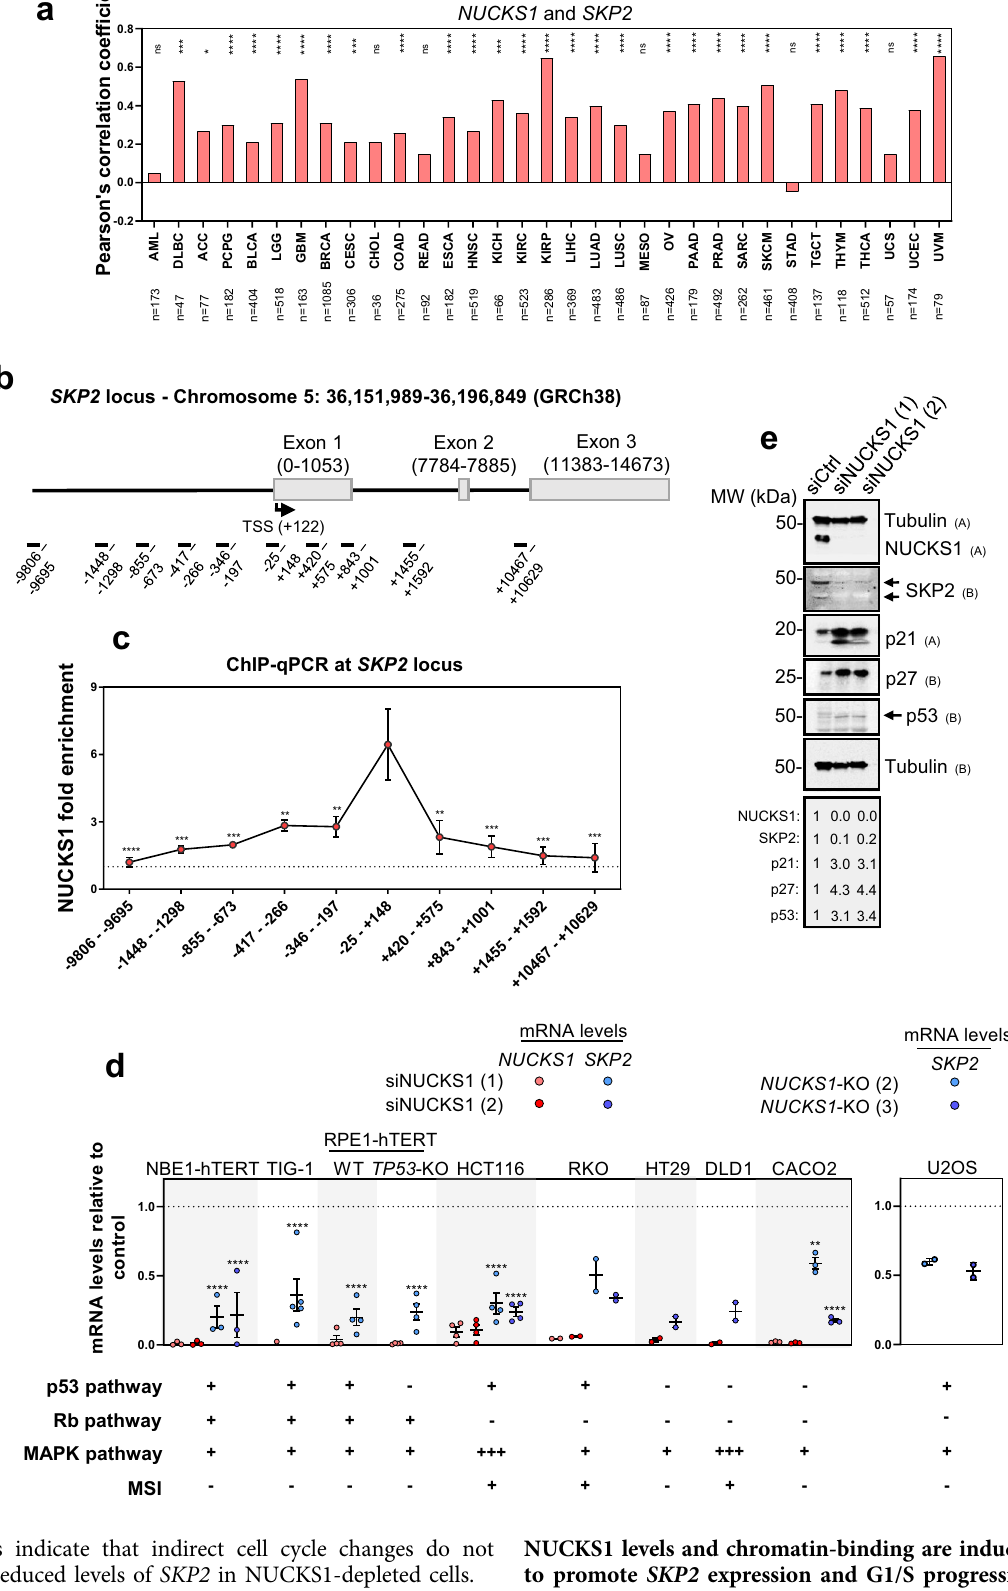
These results indicate that indirect cell cycle changes do not account for reduced levels of SKP2 in NUCKS1-depleted cells. Altogether, these data identify SKP2 as a transcriptional target of NUCKS1 and show that NUCKS1 regulates SKP2 expression independently of genetic background, and in multiple cellular contexts. NATURE COMMUNICATIONS| (2021) 12:6959